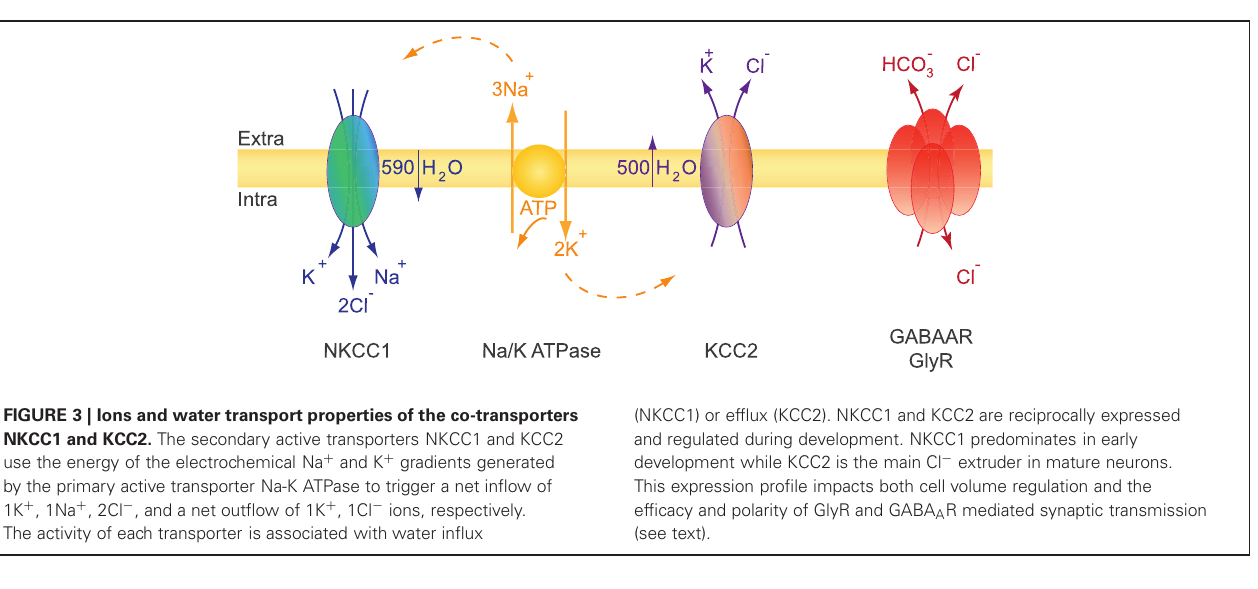
(NKCC1) or efflux (KCC2). NKCC1 and KCC2 are reciprocally expressed and regulated during development. NKCC1 predominates in early development while KCC2 is the main Cl − extruder in mature neurons. This expression profile impacts both cell volume regulation and the efficacy and polarity of GlyR and GABA A R mediated synaptic transmission (see